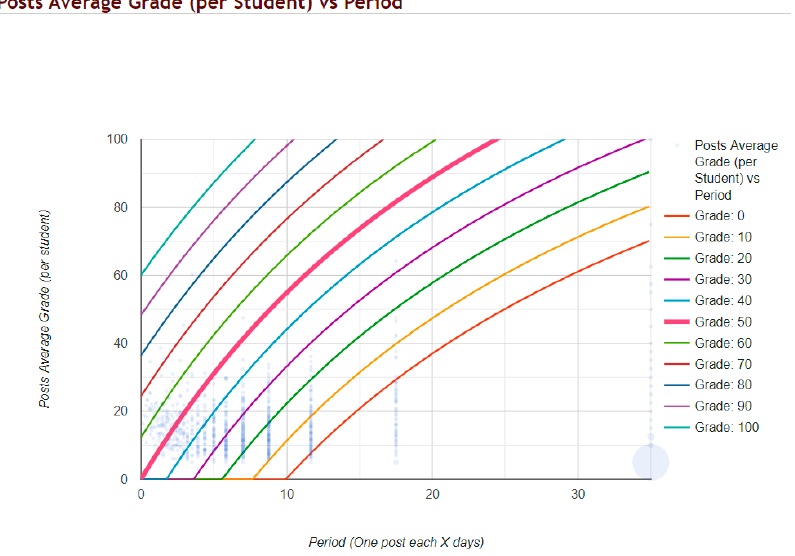
Figure 7. Example graph showing f ( x ) (Grade 50) plus some other curves calculated through the Euclidean distance to f ( x ) in the range from 0 to 100, and representing P ( x,y ) for all the learners in the course forum. The large point in the lower right corner shows learners who only sent one single, not very relevant, message. The x -axis is scaled with the length of the MOOC in days (course duration input), while the y-axis represents. The y-axis is scaled with the maximum grade (Parameter D ).